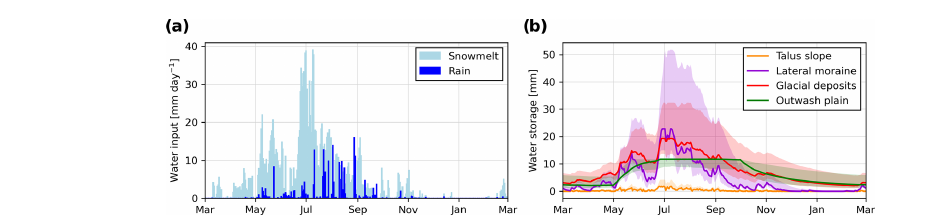
Figure 8. (a) Measured precipitation input at the glacier snout (mmd − 1 ) and mean snowmelt input simulated with a simple degree-day approach (mmd − 1 ). (b) Evolution of the groundwater storage of the four main geomorphological landforms (outwash plain; flat glacial deposits < 22 ◦ ; lateral moraines > 22 ◦ ; talus slopes > 22 ◦ ) based on the landform model described in Eqs. (12) to (14). Storage volumes in cubic meters are divided by the entire catchment area in square meters to provide comparable estimates in